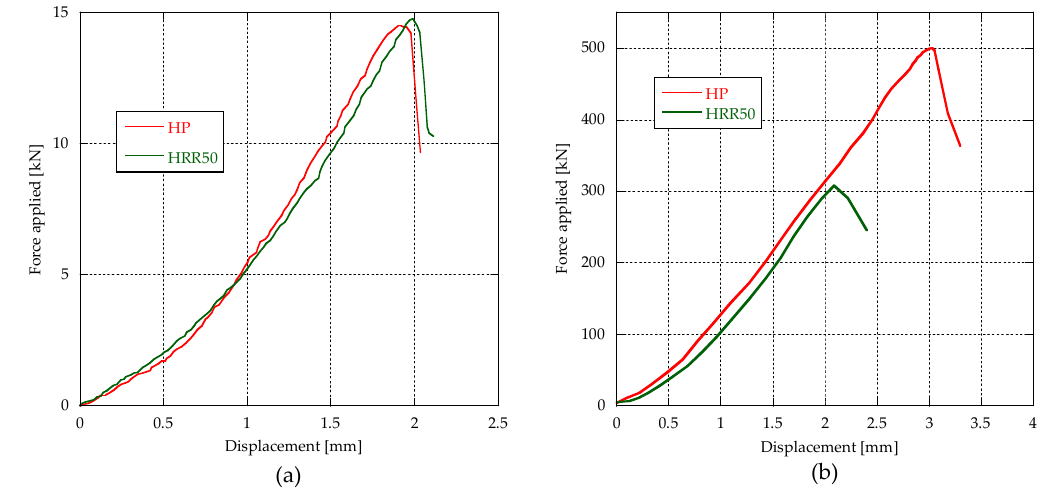
Figure 10. Mechanical characterization of precast elements: Bending test on ditches ( a ), impact test on barriers ( b ). Table 6. Splitting tensile strength.